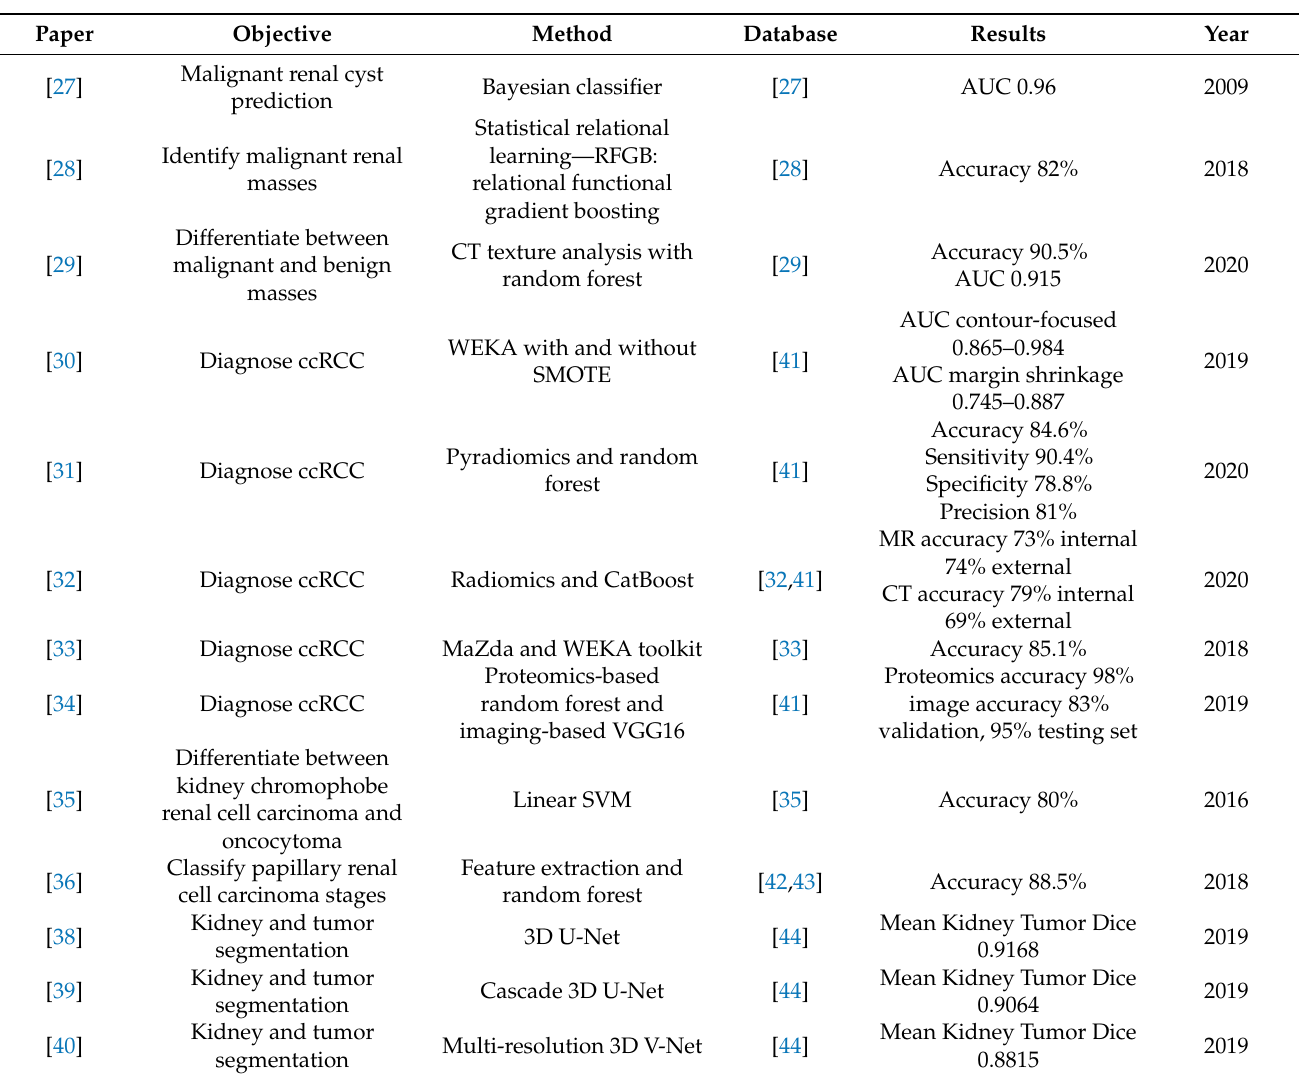
Table 1. Renal mass